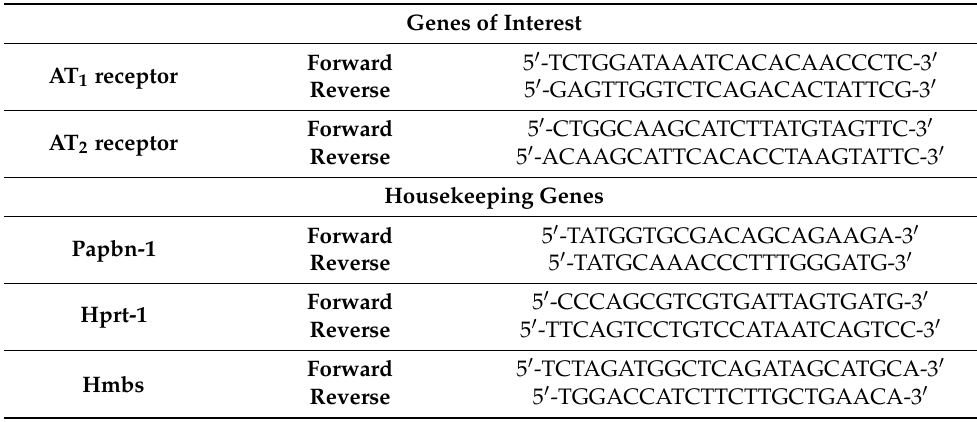
Table 3. qPCR conditions for AT 1 and AT 2 receptors’ expression